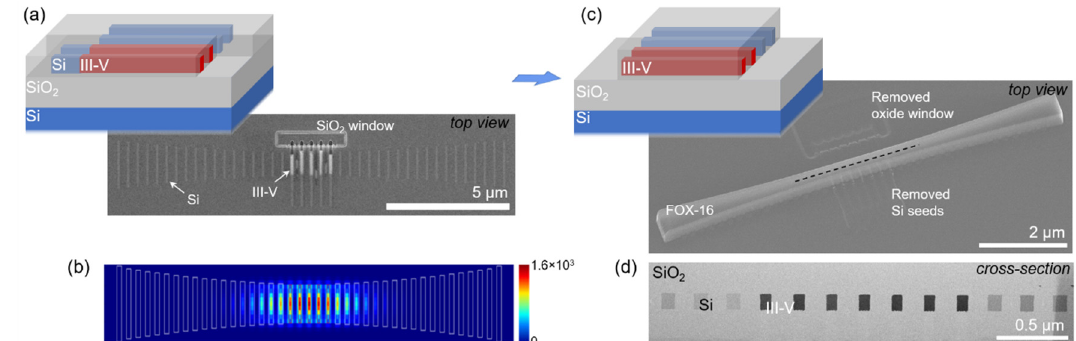
Figure 3. Fabrication of the hybrid III-V/Si photonic crystal cavities. ( a ) Schematic of the device center where some Si rods were replaced with active material. This is visible in the SEM top view (top), where the III-V material appears in a brighter color. ( b ) 3D FDTD simulated |E y | 2 field profile of the fundamental mode. A comparison with ( a ) emphasizes the high gain overlap of the selected five rods with the cavity mode. ( c ) In an additional step, a symmetric cavity is achieved by defining the device outline with FOX-16 resist and removing the surrounding oxide. The resulting structure is visible in the SEM image with the cavity hidden underneath. ( d ) A STEM cross-section along the dashed line shows that the III-V rods directly inherit the Si shape. ( a , b ) are reprinted (adapted) with permission from [33] © 2020 American Chemical Society.